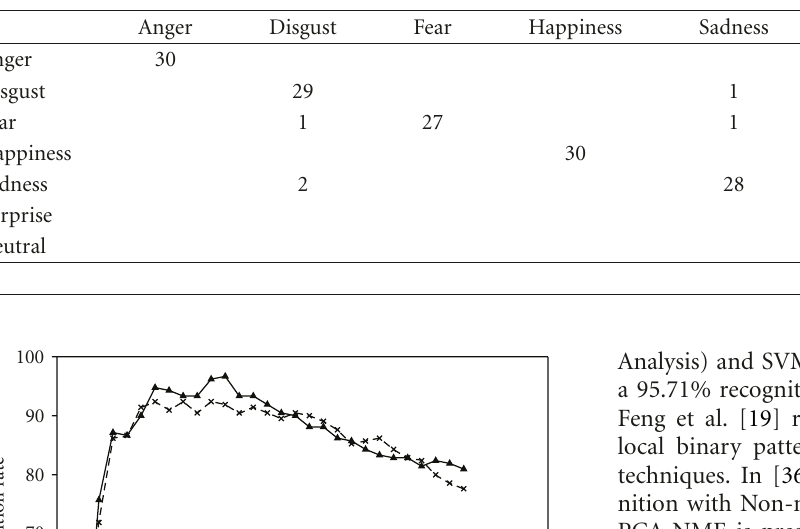
Figure 5: Seven basic emotions (from left to right): anger, disgust, fear, happiness, sadness, surprise, and neutral state (images taken from JAFFE database). Table 3: Confusion matrix of facial expression recognition.